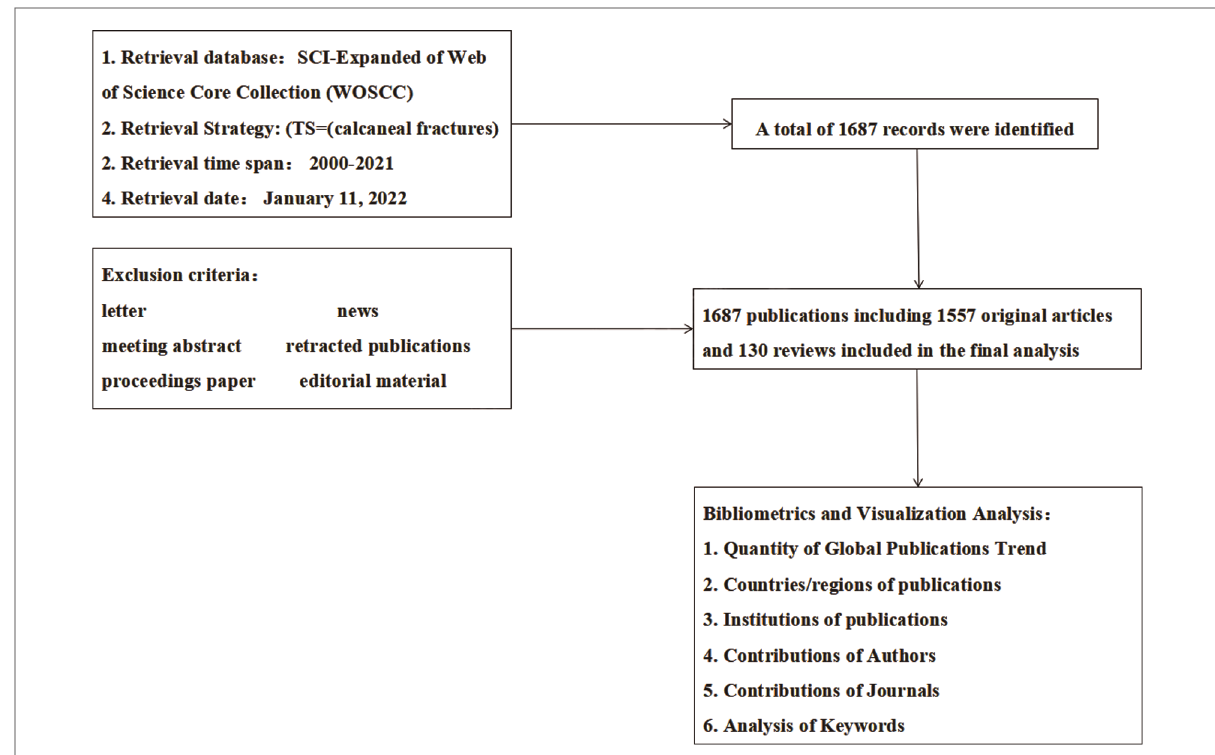
FIGURE 1 Flowchart describing the selection process for articles and reviews included in the